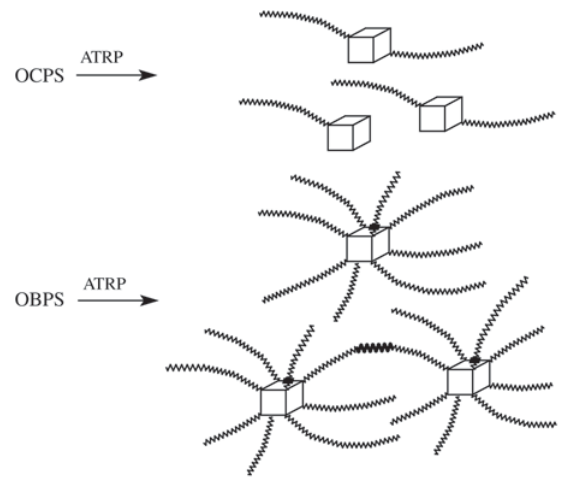
Scheme 2. Molecular architecture of PMMA hybrids initiated by OCPS and